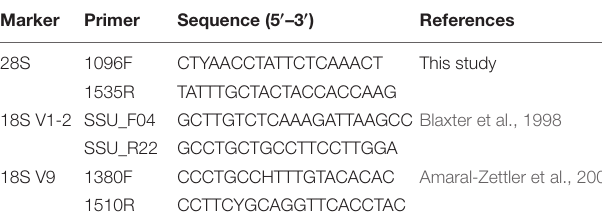
TABLE 1 | List of primers used in this